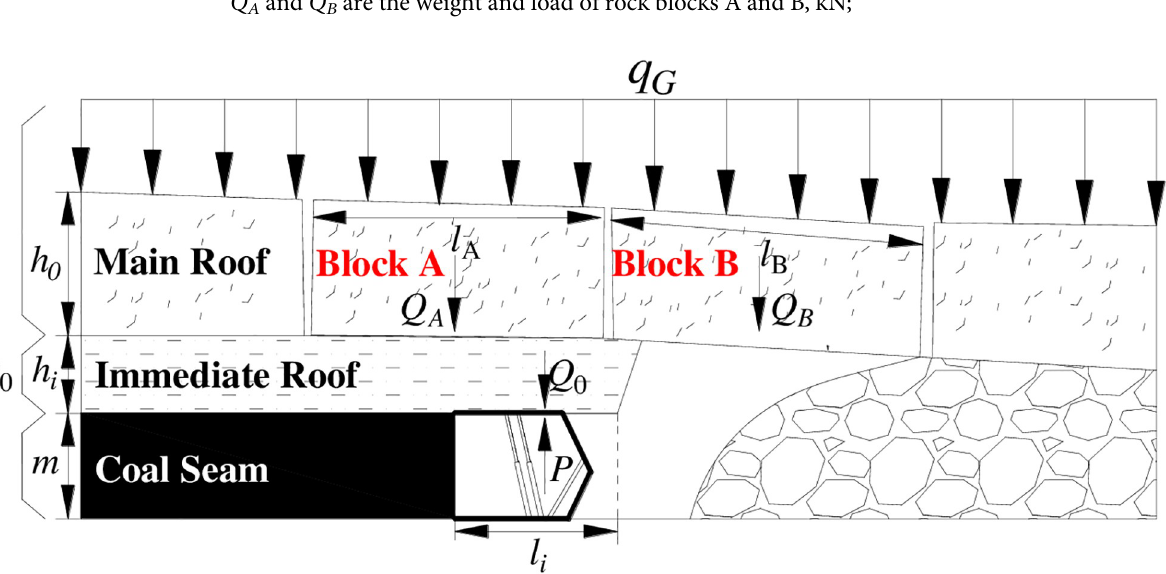
Fig 2. Unarticulated Structure of the Fractured Rock Blocks